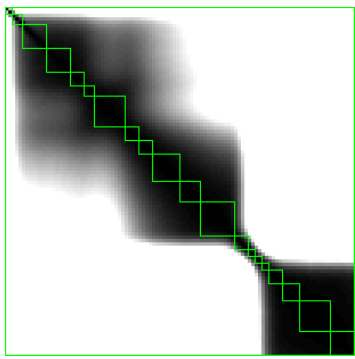
Figure 1: Examples of groups of bands superimposed on the be- tween band correlation matrix (for Pavia data set)